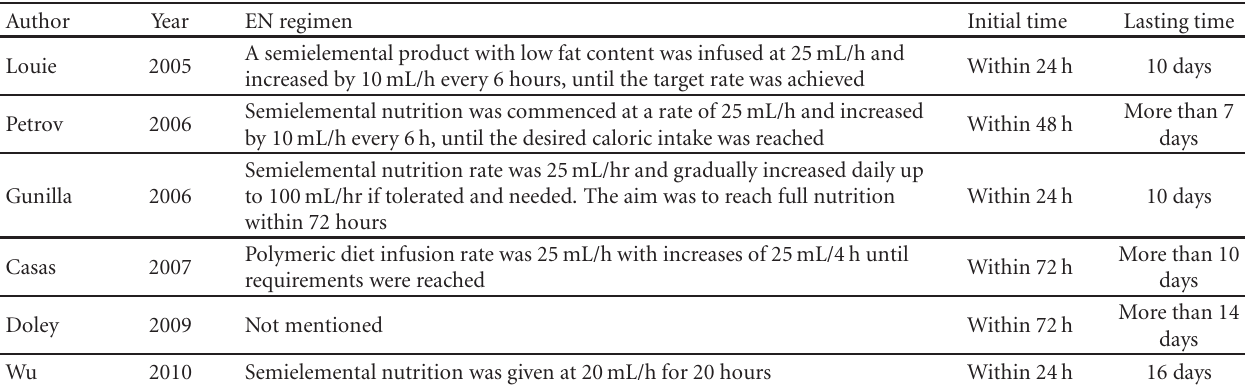
Table 4: EN regimen and